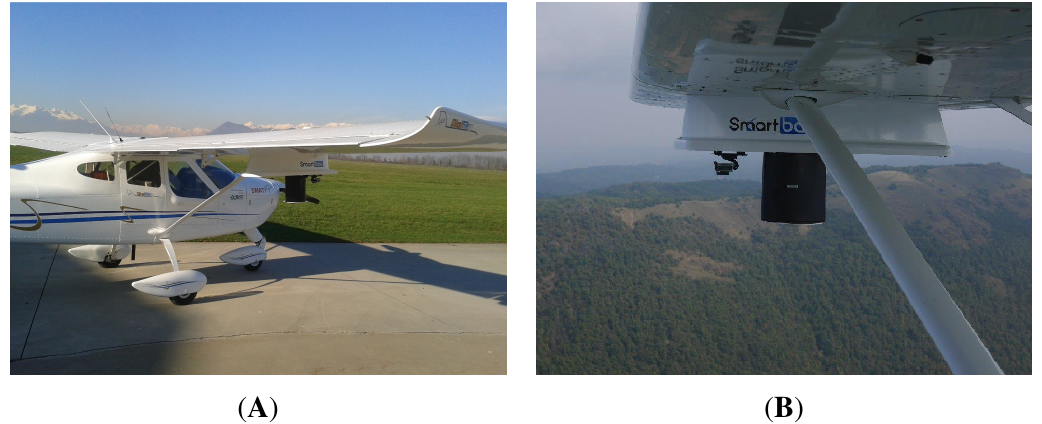
Figure 8. Sensor prototype mounted on the manned Digisky Tecnam P92 aircraft ready to take off ( A ) and during the flight ( B ).